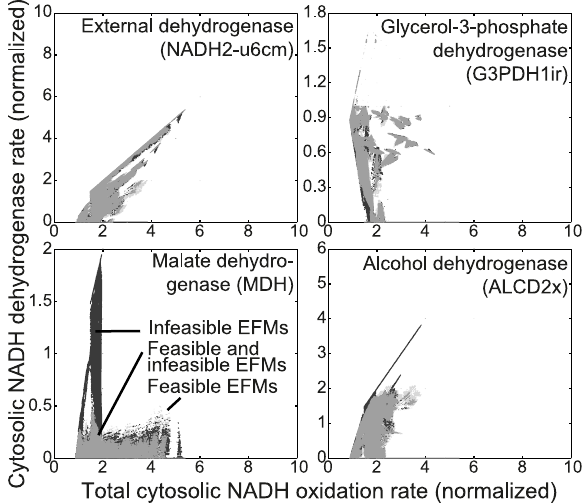
Figure 6. Cytosolic NADH oxidation rates of specific reactions versus the total cytosolic NADH oxidation rate for EFMs. The reaction name is shown on each plot, with the reaction name in the metabolic model in brackets. Every dot represents one or more EFMs at the respective combination of oxidation rates. A grey shade represents a combination where both feasible and infeasible EFMs are present. The rates are normalized to the glucose uptake rate of each EFM.